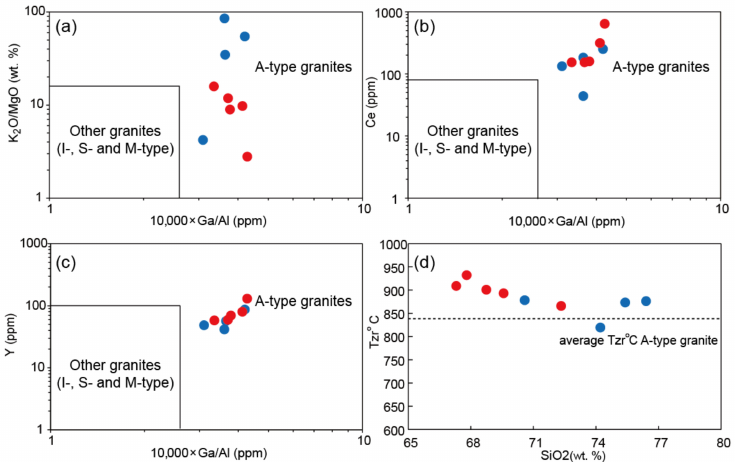
Figure 11. ( a – c ) Genetic discrimination diagram for the Statherian granitoids [47]. ( d ) Zircon saturation temperature ( T zr ◦ C = In D Zrzircon/melt — − 3.80 − [0.85( M − 1)] + 12,900/ T suggested